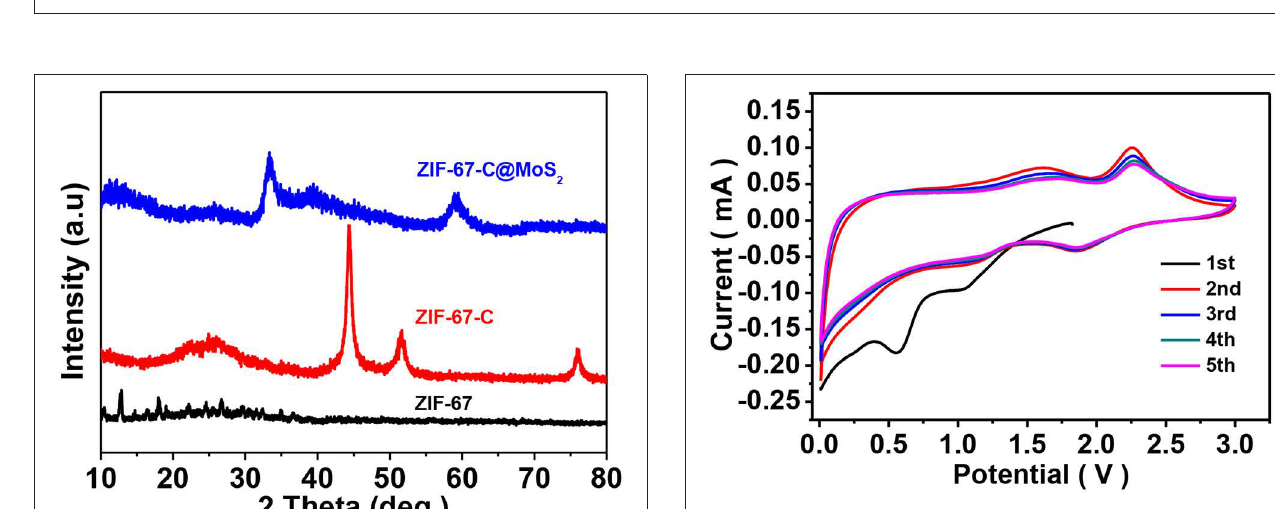
FIGURE 3 | SEM images of ZIF-67-C@MoS 2 (a–c) , elemental mapping showing the uniform distribution of C, O, Mo, and S elements in ZIF-67-C@MoS 2 composite (d–h) .